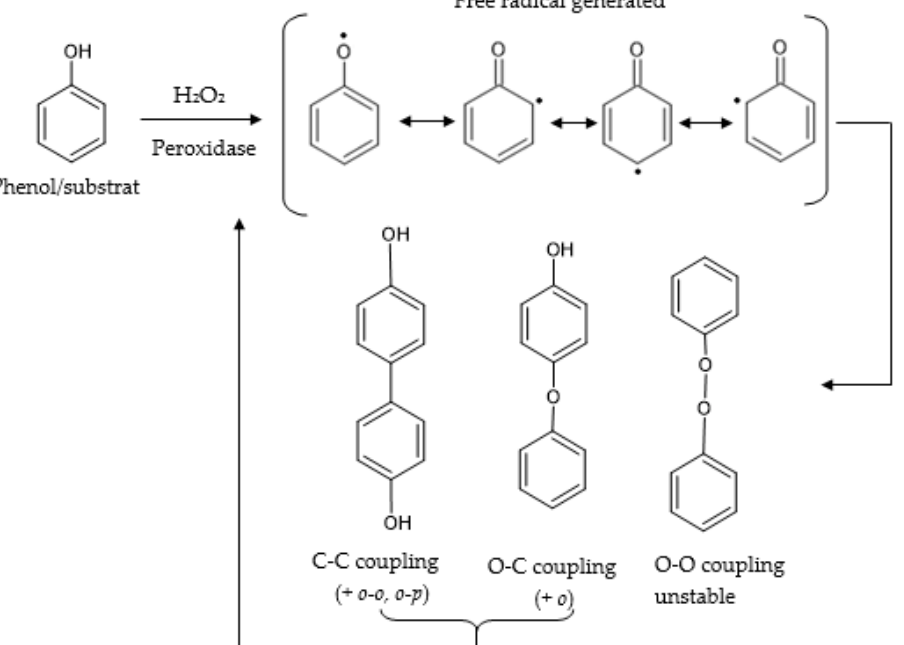
Figure 8. The mechanism of the oxidation reaction of phenolic compounds catalyzed by the perox- dase idase enzyme.